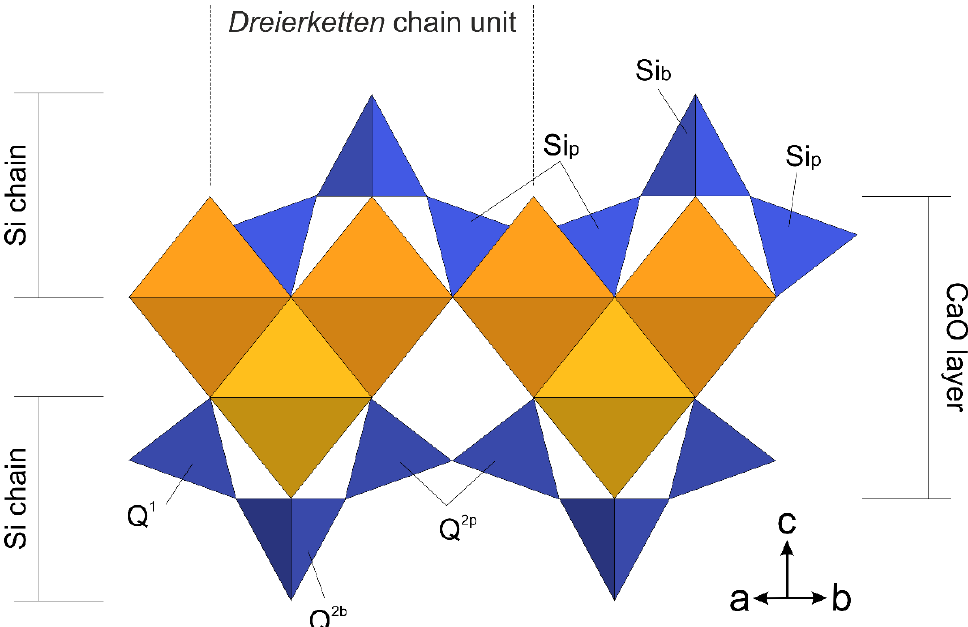
Figure 1. Sketch of the tobermorite-like structure of a layer of sevenfold-coordinated Ca 2+ ions (orange) sandwiched by linear chains of silicate tetrahedra (blue) formed by repeating dreierketten chain units. Silicate bridging (Si b ) and paired (Si p ) tetrahedra are shown in the sketch. Q n notation of silicate tetrahedra used in 29 Si MAS-NMR analysis (see Section 3.4) is also reported.